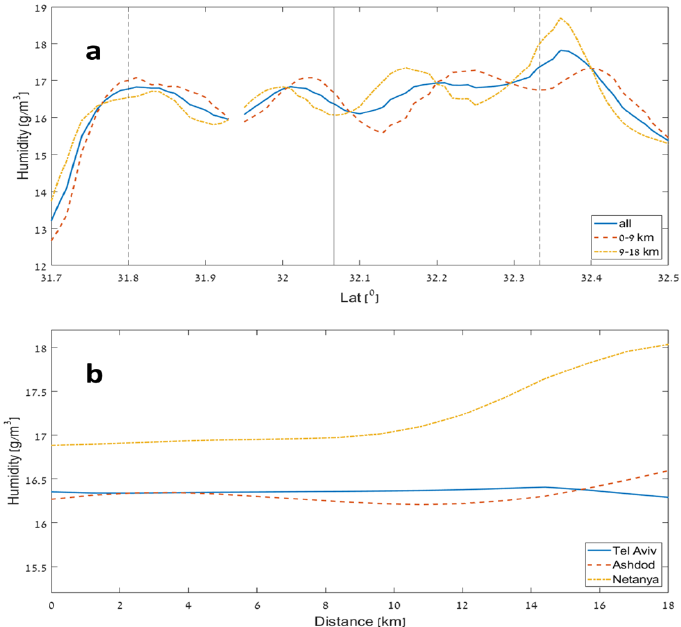
Figure 6. ( a ) A cross-section of humidity averages for two strips along the coastline: the first 9 km from the shore (red dashed line, coastal strip) and the area between 9 and 18 km from the shore (yellow line, inner strip), and the average humidity for the full 18 km strip (blue solid line). The Tel Aviv latitude is indicated by the solid vertical line, and Ashdod and Netanya latitudes are represented by the dotted vertical lines, with Ashdod in the south and Netanya in the north. ( b ) A cross-section of humidity averages as a function of the distance from the coast for Netanya (yellow), Tel-Aviv (blue), and Ashdod